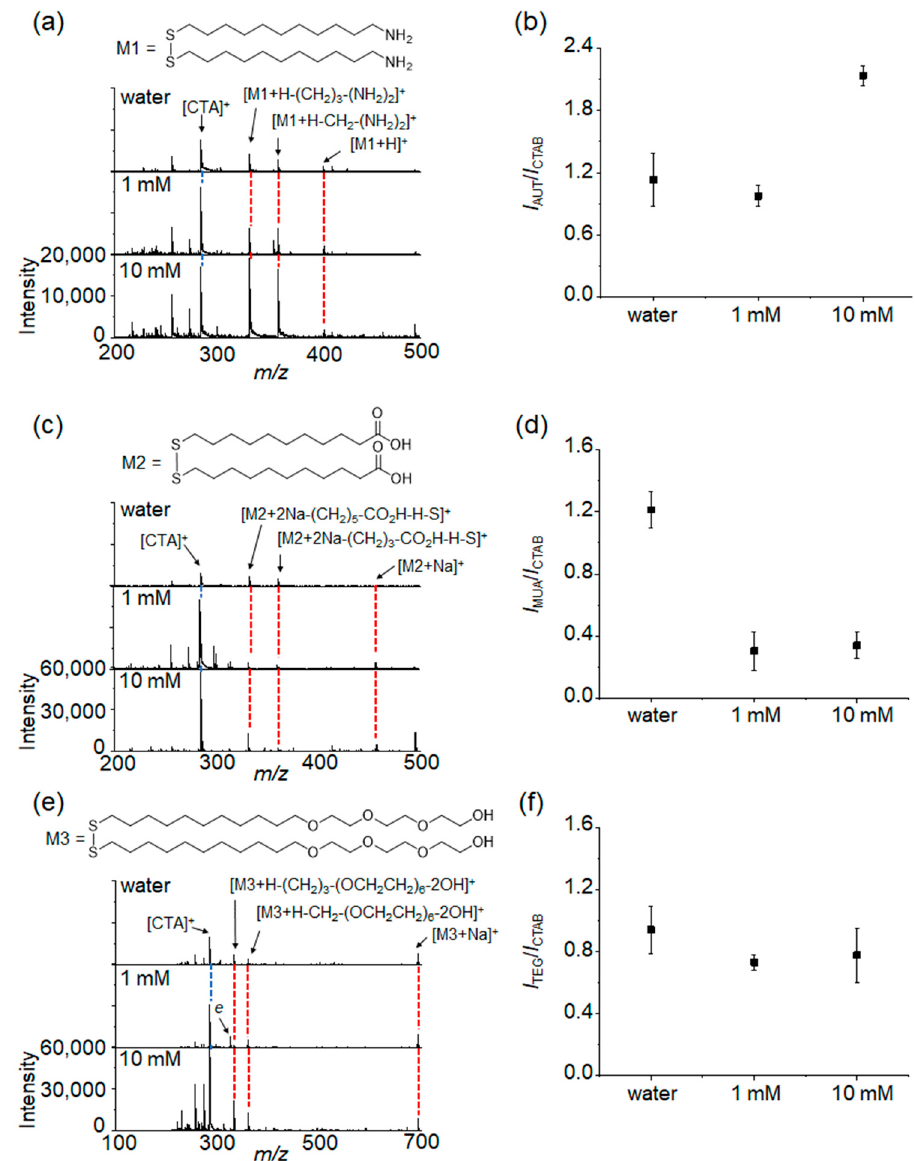
Figure 5. ( a ) LDI-TOF-MS spectra of ligand-exchanged Au NRs with ( a ) AUT, ( c ) MUA, and ( e ) TEG and the relative intensity ratios of the mass peaks derived from the residual CTAB and thiol ligands such as ( b ) AUT, ( d ) MUA, and ( f ) TEG on the modified Au NRs prepared in water and 1 mM and 10 mM CTAB. The average I ligand / I CTAB ratios were obtained from at least five different measurements.